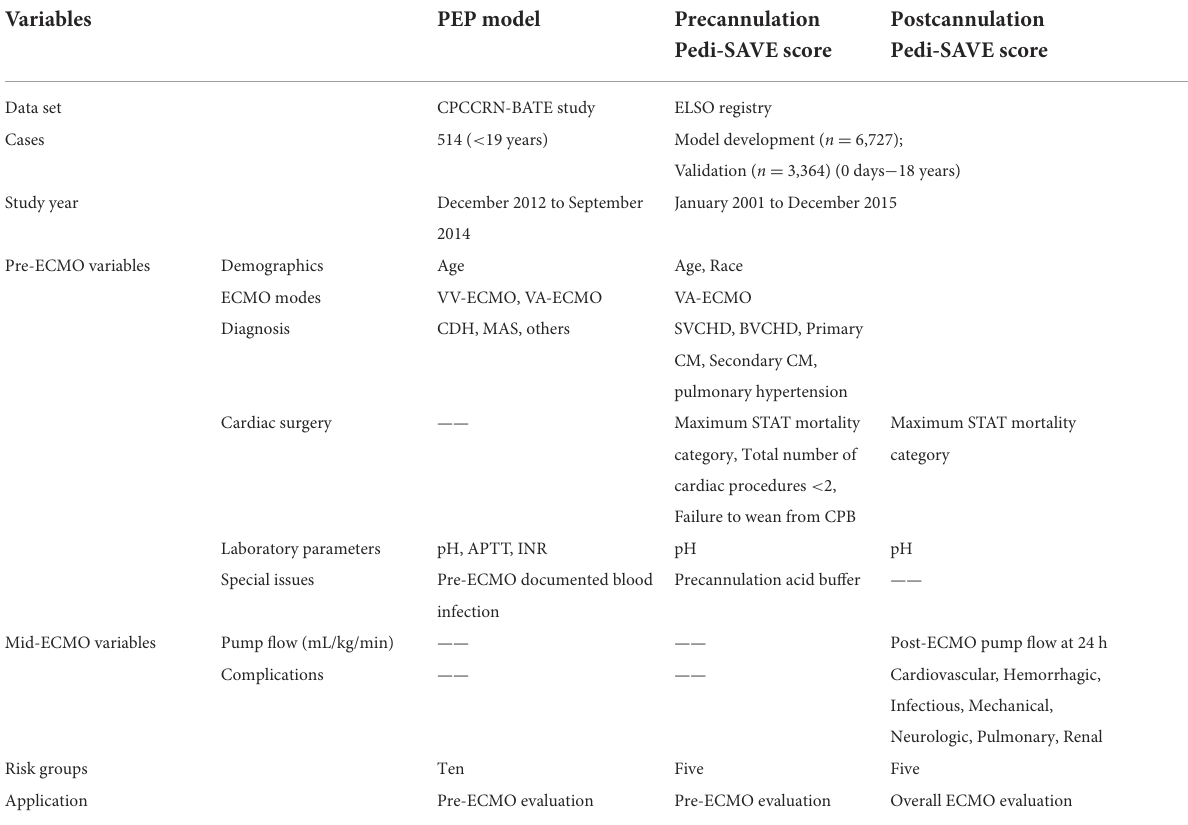
TABLE 1 Details of the pediatric ECMO prediction